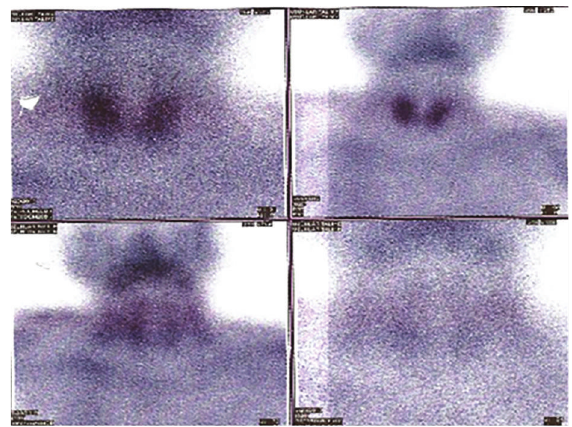
Figure 2: Tc 99 m sestamibi scan showing radioactive contrast media excretion; no focal retention compatible with parathyroid ade- noma/hyperplasia observed in neck or mediastinum.